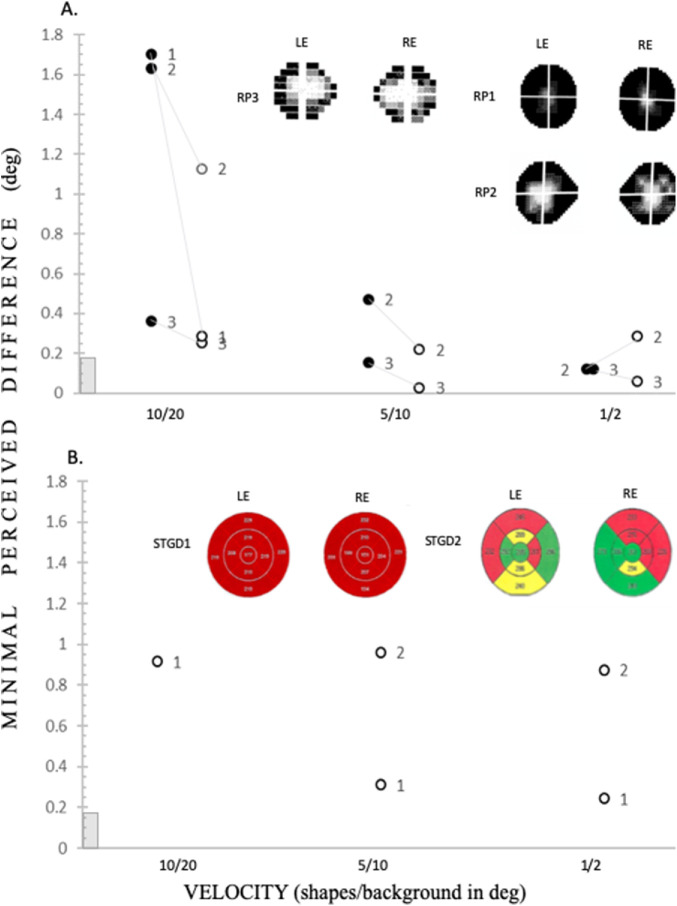
Velocity-based acuity thresholds in patients with RP and patients with STGD performed in unrestricted visual field. The individual acuity thresholds for the minimal perceived difference between circle and ellipse dimensions in visual degrees. Note that decreasing velocity resulted in improved acuity thresholds in both contrasts. (A) Patients with RP. Improvement of performance along with a decrease in velocity is observed. Note RP2 has an elevated threshold for the positive contrast with the slowest velocity. RP1 performed only in the fastest 10/20 degrees per second velocity-based task. The grayscale of the Humphrey field analysis (30-2) for each patient is shown. (B) Patients with STGD. Note that both patients refused to work in negative contrast. In positive contrast, STGD1 performed at slower velocities, but no improvement in acuity along with a decrease in velocity was observed. STGD2 showed improved performance with decreasing velocity. The velocity of the task is presented in order of testing from fastest to slowest: 10/20, 5/10, 1/2 (velocity within shapes versus in the background degrees per second). The OCT results for both patients are shown: STGD1 all sectors < 1%, STGD2, yellow 1 to 5%, green > 5%, and red < 1%. Other denotations as in Figure 2.